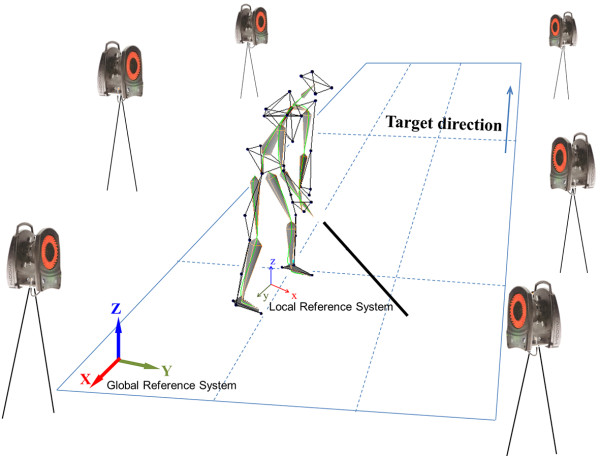
Golf swing analysis system.